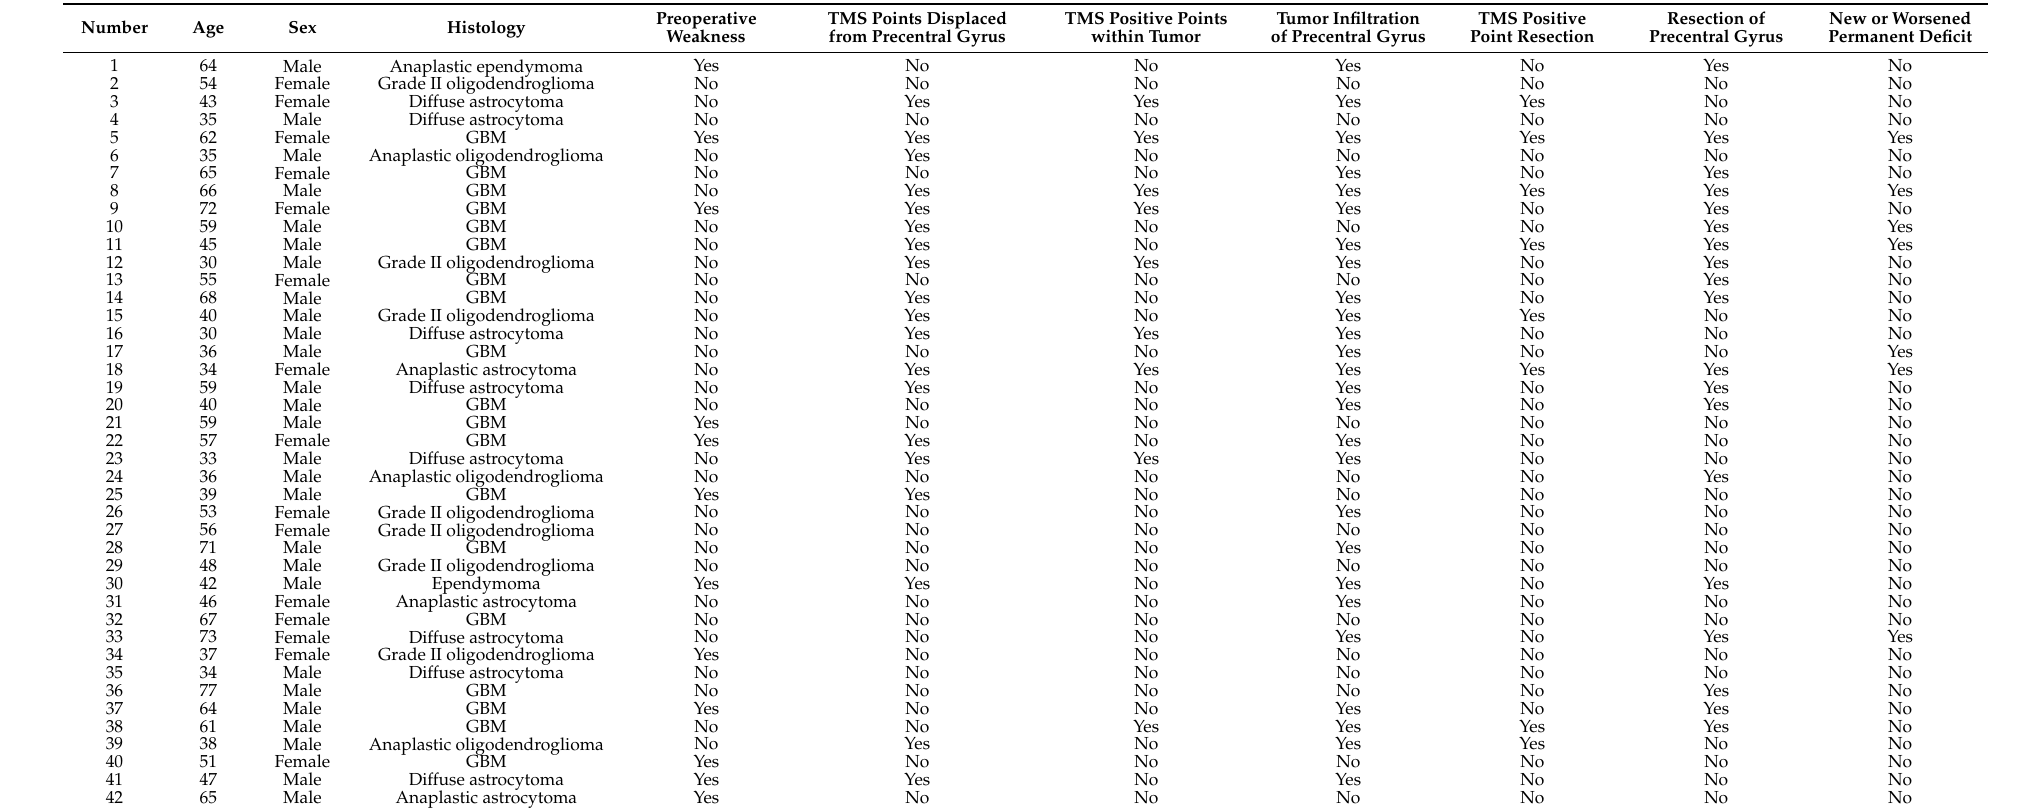
Table 1. Patient